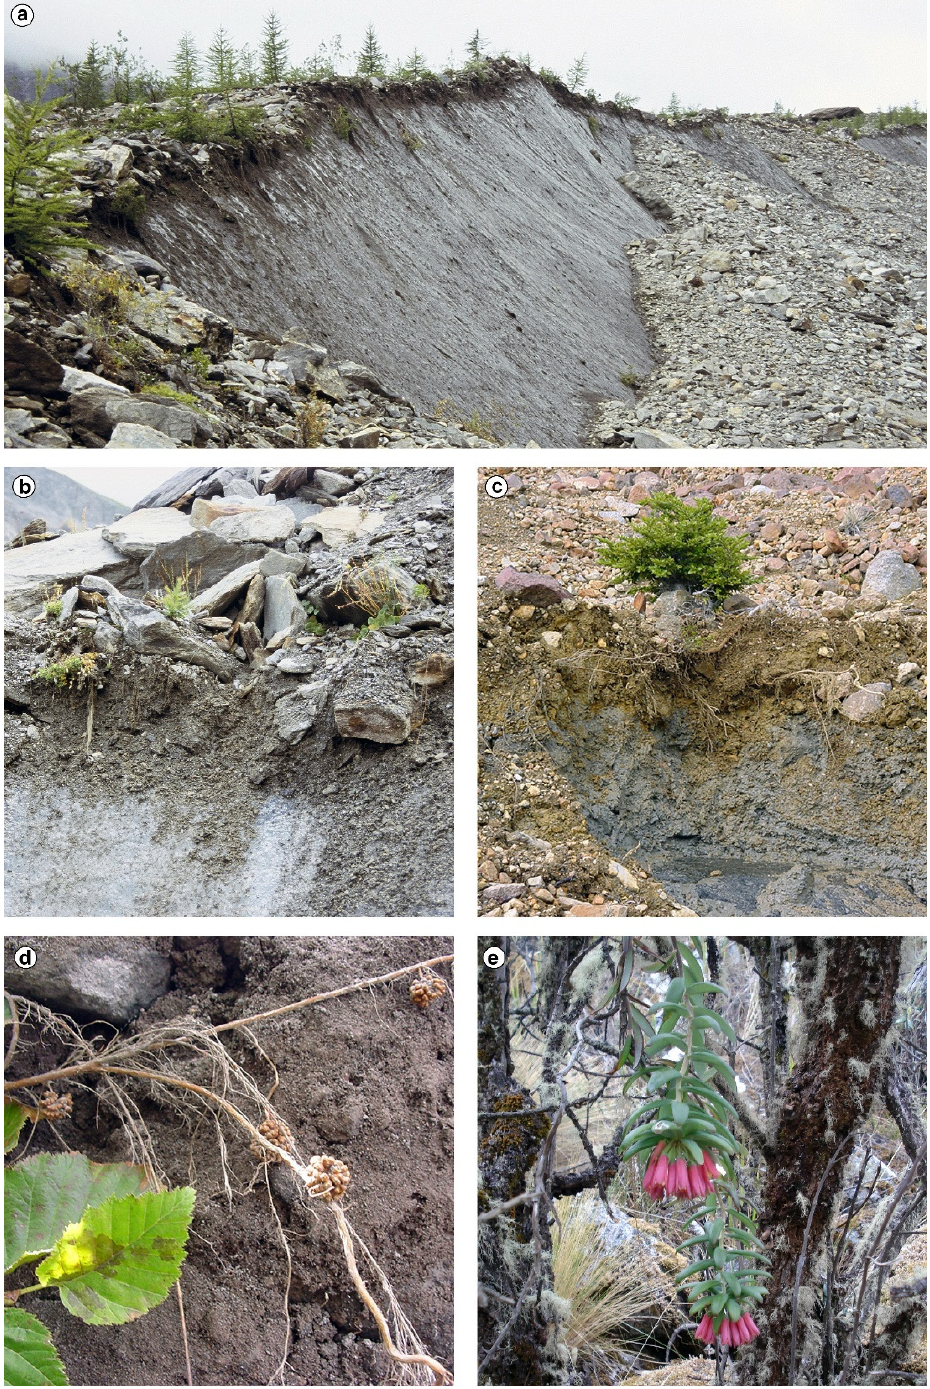
Figure 5. Aspects of plant growth on debris-covered glacier surfaces: ( a ) Larix decidua dominated plant community on Miage Glacier (European Alps, Italy); ( b ) detail view of the contact zone of ice and plants (amongst others: Oxyria digyna , Cerastium uniflorum and a Larix decidua seedling) on debris-covered Miage Glacier (European Alps, Italy); ( c ) Nothofagus dombeyi on debris-covered Ventisquero Blanco (Andes, Southern Chile)—note the gleyic soil due to water saturation caused by the underlying ice; ( d ) Alnus viridis ssp. sinuata on debris-covered Carbon Glacier with the symbiotic actinomycete filamentous nitrogen-fixing bacterium Frankia alni on its roots (Mount Rainier, Washington, DC, USA); ( e ) the epiphytic lily-of-the-Incas Bomarea albimontana on a Polylepis -tree growing on the supraglacial debris of Kinzl Glacier (Peruvian Andes) (photos: ( a , b ) Th. Fickert; ( c ， d ) F. Grüninger; ( e ) M. Richter) .